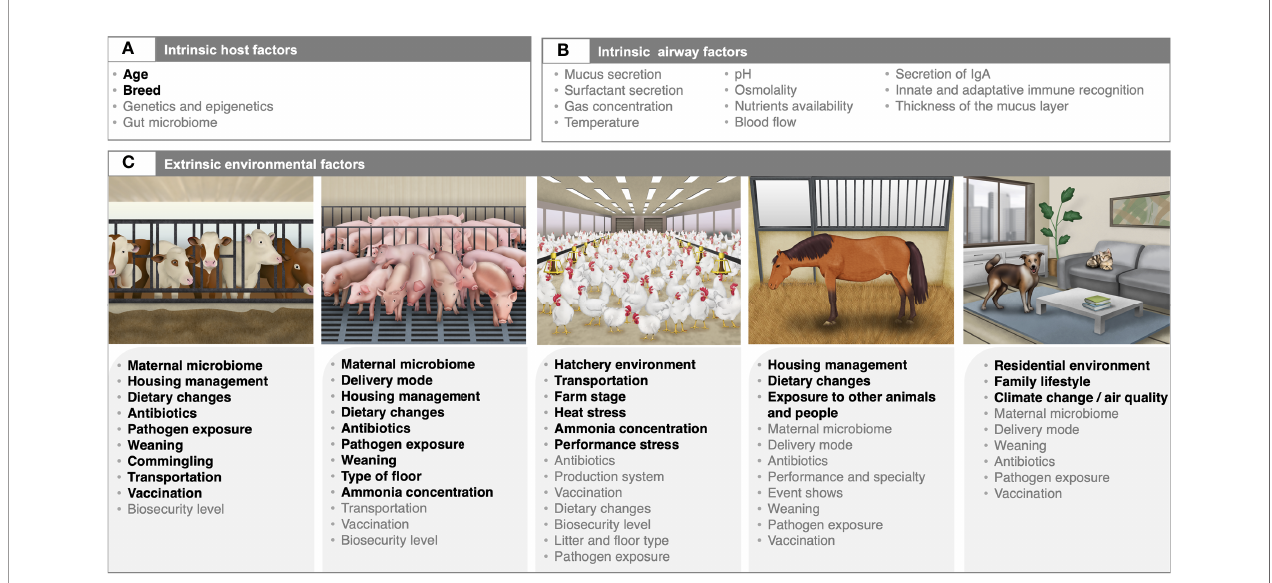
FIGURE 2 | Intrinsic and extrinsic factors affecting the composition and development of the airway microbiota in domestic animals. The respiratory tract microbiota composition and development are dynamic and are shaped by various intrinsic host factors (A) , as well as intrinsic airway milieu conditions (B) , and environmental variables (C) . Factors highlighted in bold are based on published literature. For ruminants and swine, factors are mainly extracted from the review by Zeineldin et al. (2019) and Pirolo et al. (2021), respectively. Variables colored in grey are those that illustrate directional hypothesis made by the authors. Written permission for publication of the domestic animals ’ drawings in the fi gure has been taken, except for the horse drawing. Horse drawing has been obtained from Mach et al.